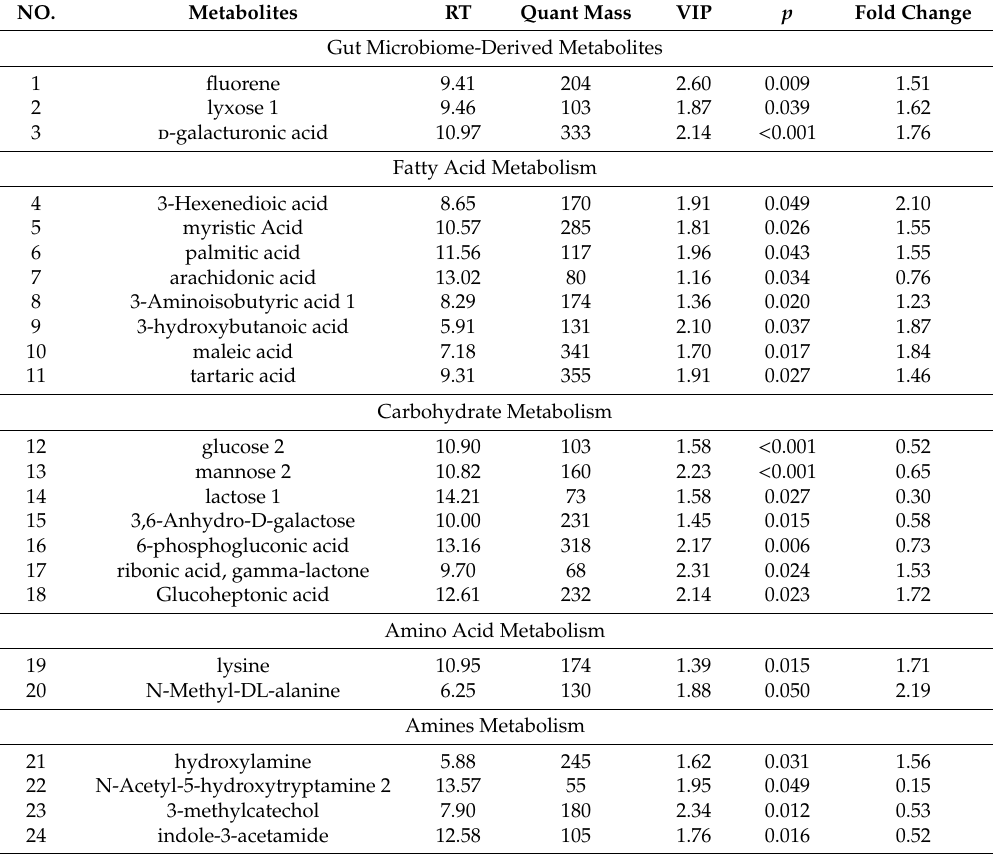
Table 2. Metabolites with significantly di ff erent levels in the serum of thermal neutral (TN) or heat stress (HS) finishing